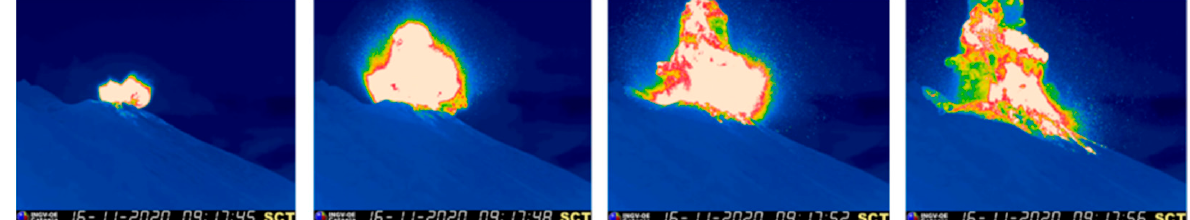
Figure 8. Sequence of thermal images acquired from the camera of the INGV monitoring network at Stromboli during the 16 November 2020 paroxysm.